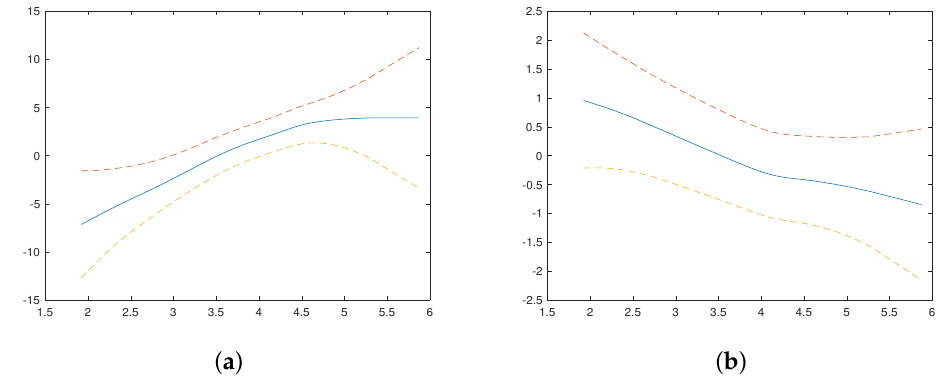
Figure 12. Plots of (cid:98) β 1 ( a ) and (cid:98) β 2 ( b ) and their approximate SE band, indicated by the discontinu- ous